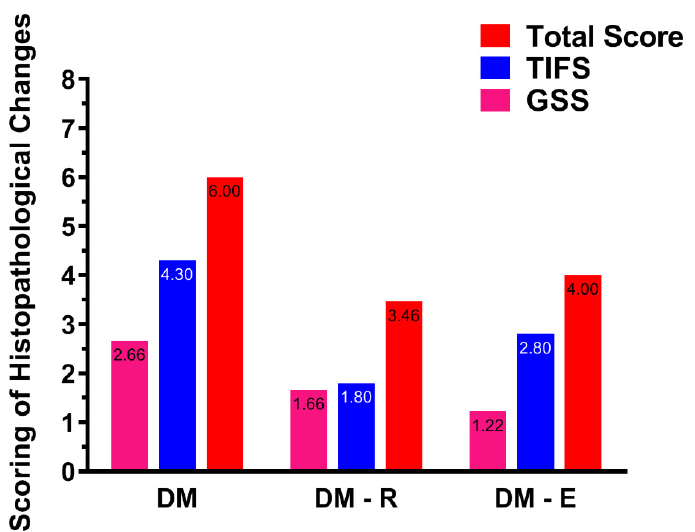
Figure 5. The effect of treatments with enalapril and ruxolitinib on GSS and TIFS in the studied groups. Treatment with ruxolitinib resulted in an almost equal reduction of GSS and TIFS ( p = 0.14 and 0.03, respectively). The effect of enalapril treatment was more significant on GSS than on TIFS ( p = 0.04 and 0.02, respectively). DM, diabetic non-treated group, DM-E, diabetic enalapril-treated group (10 mg · kg − 1 ), DM-R, diabetic ruxolitinib-treated group (moderate dose of 2.2 mg · kg − 1 ).